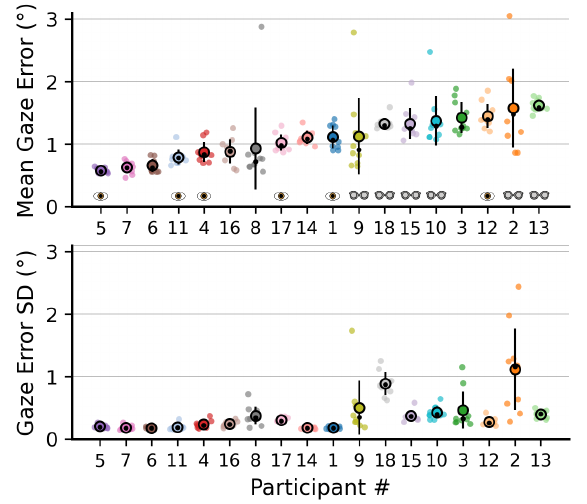
Figure 5. Accuracy (mean gaze error, top) and precision (standard deviation, bottom) of all individual participants. Small colored circles represent individual validation sessions. Large, open circles and error bars indicate mean and standard deviation across sessions, small black circles the median. Participants are sorted by average accuracy, numbers follow Table S1. Icons in the top panel indicate that a participant wore glasses or contact lenses (eye icon). Icons designed by OpenMoji